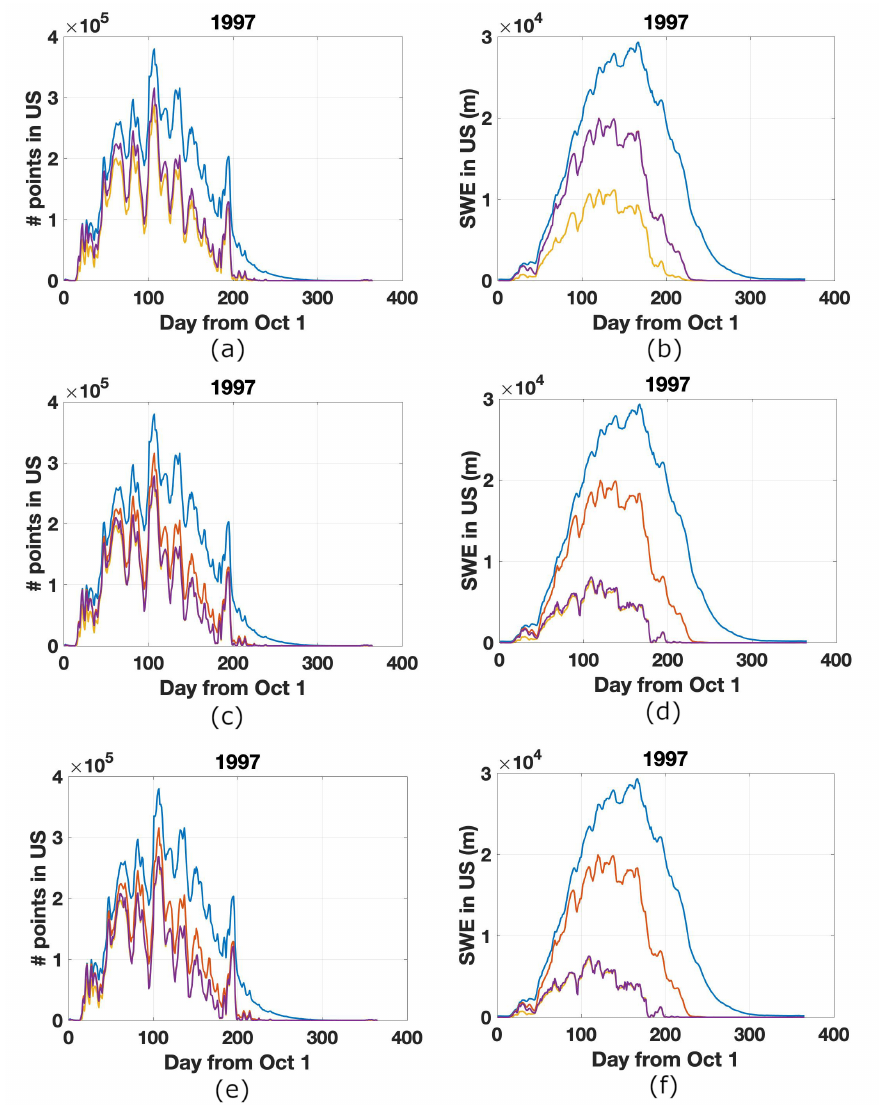
Figure 5. Time series of points in 1997 over US at ( a ) 1 GHz, ( c ) 13.5 GHz, ( e ) 17.25 GHz. Time series of SWE(m) in 1997 over US at ( b ) 1 GHz, ( d ) 13.5 GHz, ( f ) 17.25 GHz. Blue curve shows the time series of all the snow. Red curve shows the time series of dry snow (wetness less than 1%). Yellow line shows the time series of the snow that is dry, lays over flat ground, and is of depth larger than the penetration depth (required by the dual-pol. dual-freq. retrieval method). The purple line shows the time series of the snow that is dry, is of depth larger than the penetration depth, and has a daily interferometric phase change less than 2 π (required by the differential interferometric retrieval